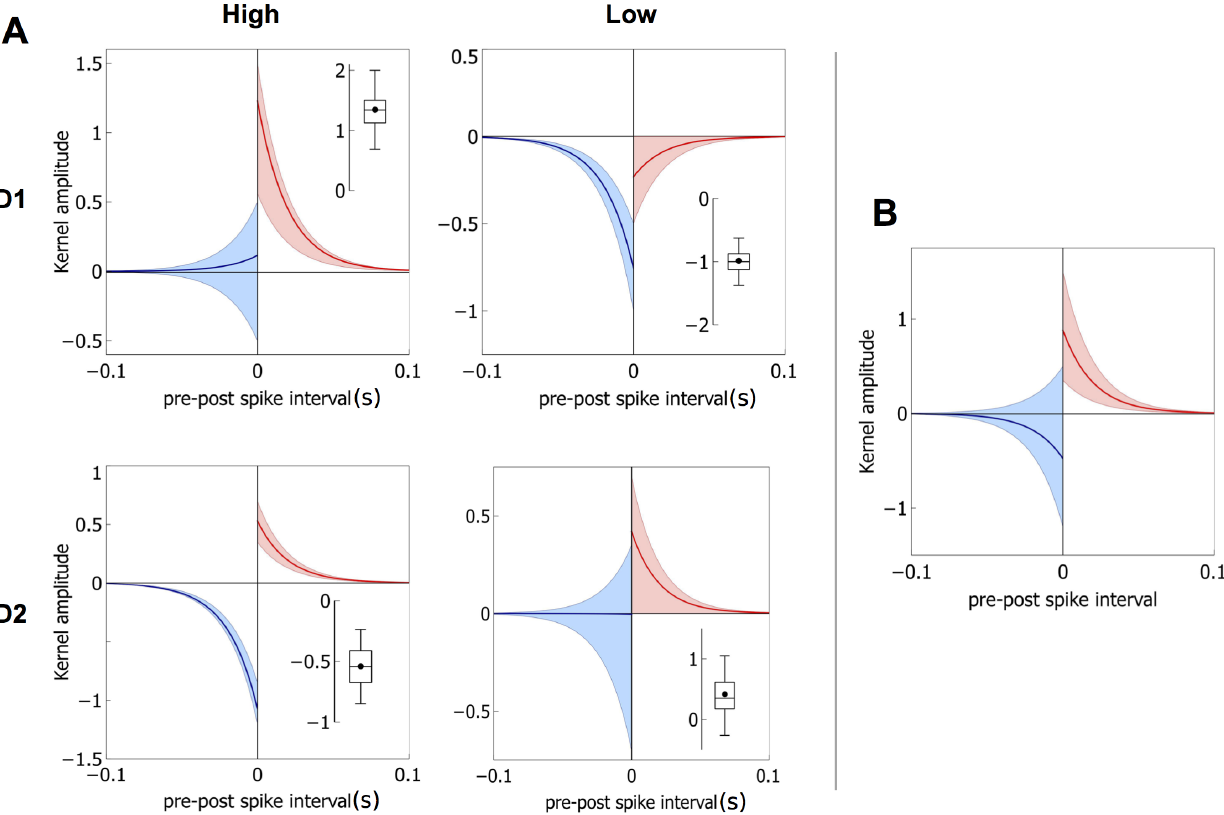
Figure 11. The plasticity rules obtained under the exhaustive search with the plasticity coefficients of Figure 10. In (A), each plot shows the range of the resulting plasticity functions for positive and negative spike-pair timing in pale red and blue, respectively, with the mean shown by solid lines. The plot layout is the same as that used in Figures 4 and 10. The box-and-whisker inset plots show the quartiles, medians, extrema, and means (black dots) of the sum k z z k { , for each function pair in Figure 10; this gives a measure of the overall direction of plasticity, given a random sampling of pre-post spike pair timings. (B) The extent and mean of the plasticity functions at high dopamine levels across D1 and D2 type MSNs combined (from left column of plots in (A)).